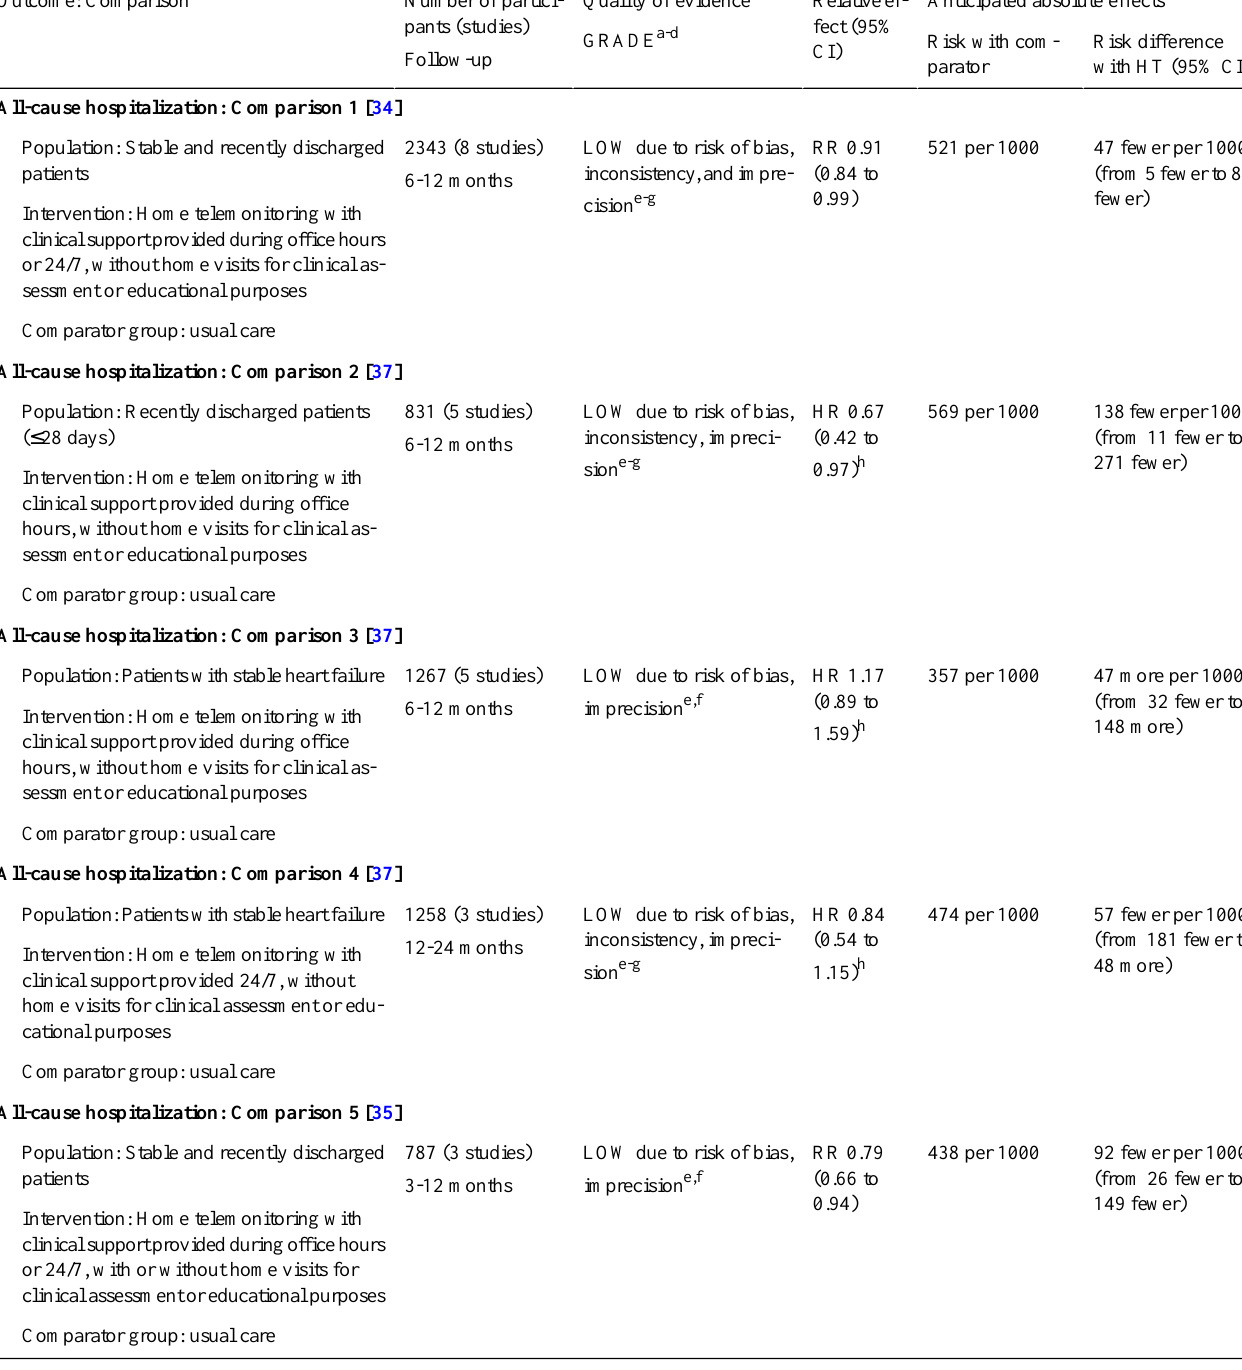
Table 8. Summary of findings from the meta-analyses with the most direct evidence in each group for the outcome of all-cause hospitalizations.